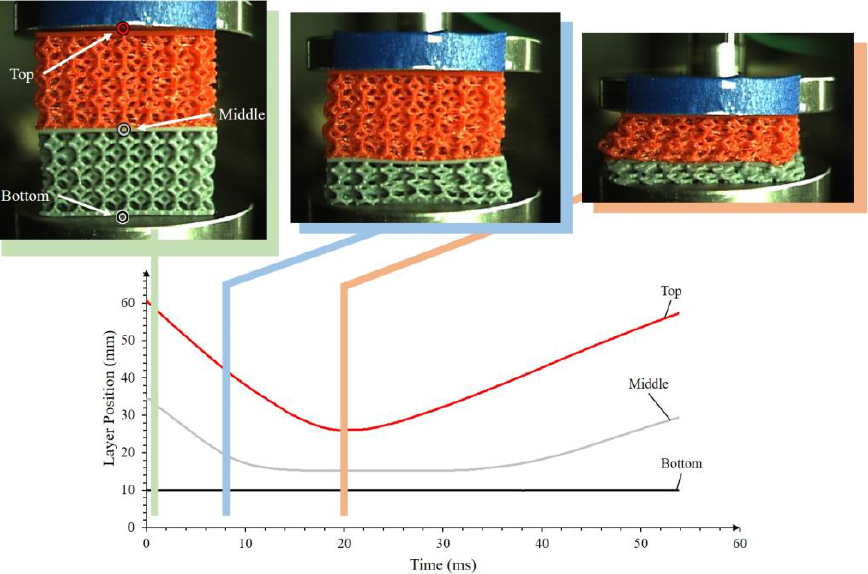
Figure 7. Deformation versus time for intermediate layers of the hybrid approach at a 14.3 J impact. Note that the bottom metal plate thickness is included here and is 10 mm.